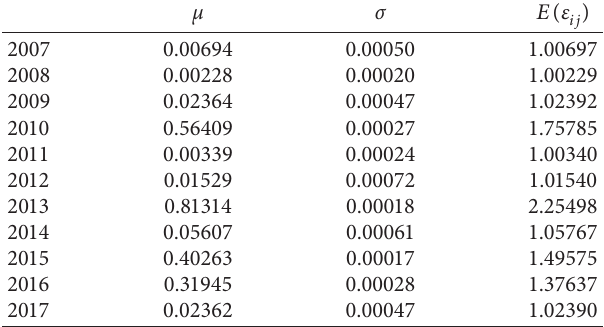
Table 4: Optimized